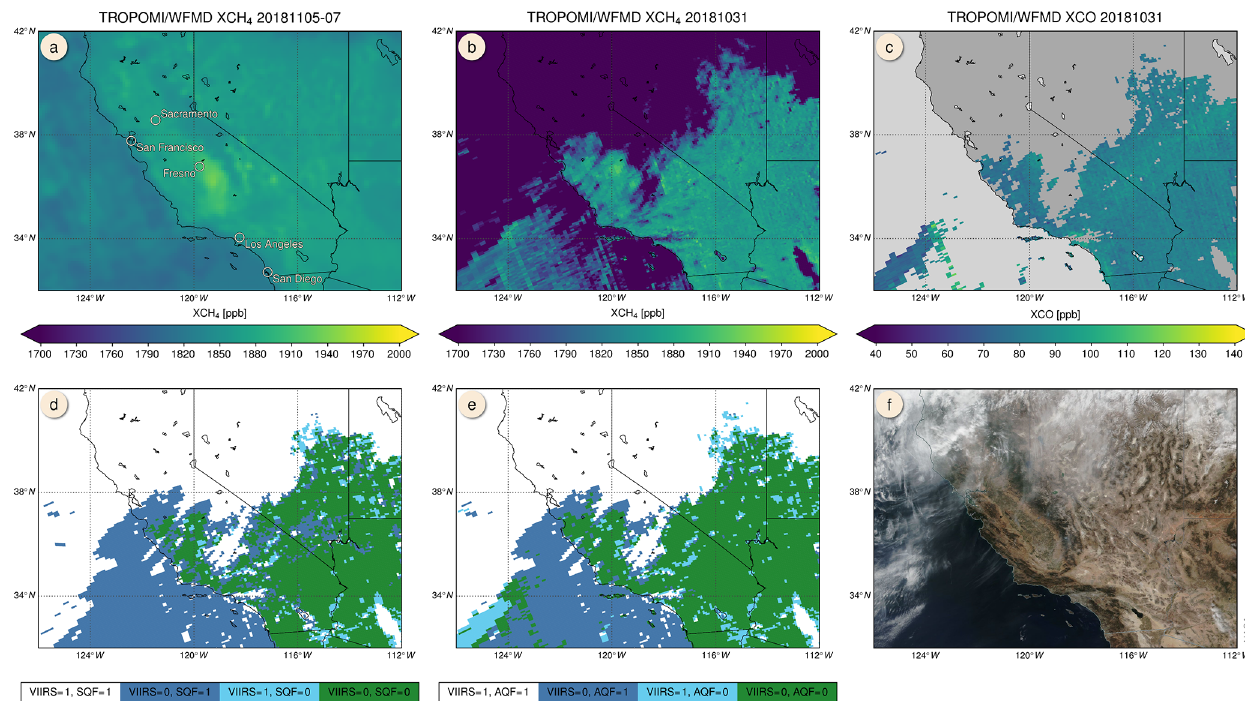
Figure 2. Performance of the implemented quality filter for the example day 31 October. (a) Cloud-free reference XCH 4 abundances (5– 7 November). (b) Unfiltered XCH 4 data. (c) XCO after application of the filter removing scenes with unrealistic low XCH 4 . (d) Comparison of the standard quality filter (SQF, 1: excluded) with the VIIRS cloud classification (1: cloudy). Matching classifications are shown in white and green (agreement with VIIRS: 78%, passing SQF: 32%). (e) As before but for the alternative quality filter (AQF) used in the presented analysis (agreement with VIIRS: 81%, passing AQF: 39%). (f) VIIRS true colour